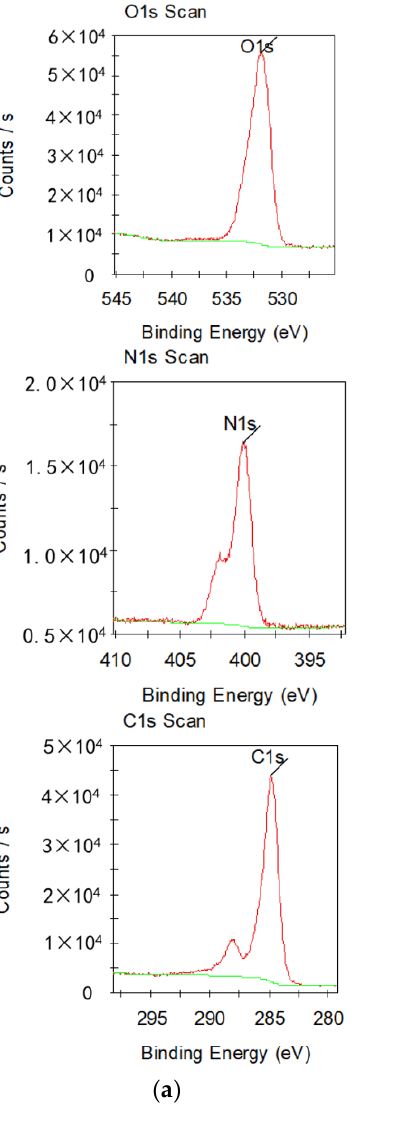
Figure 5. X-ray photoelectron spectroscopy (XPS) test results before and after modification of aramid insulation paper ( a ) F0 Sample XPS; ( b ) F3 Sample XPS.